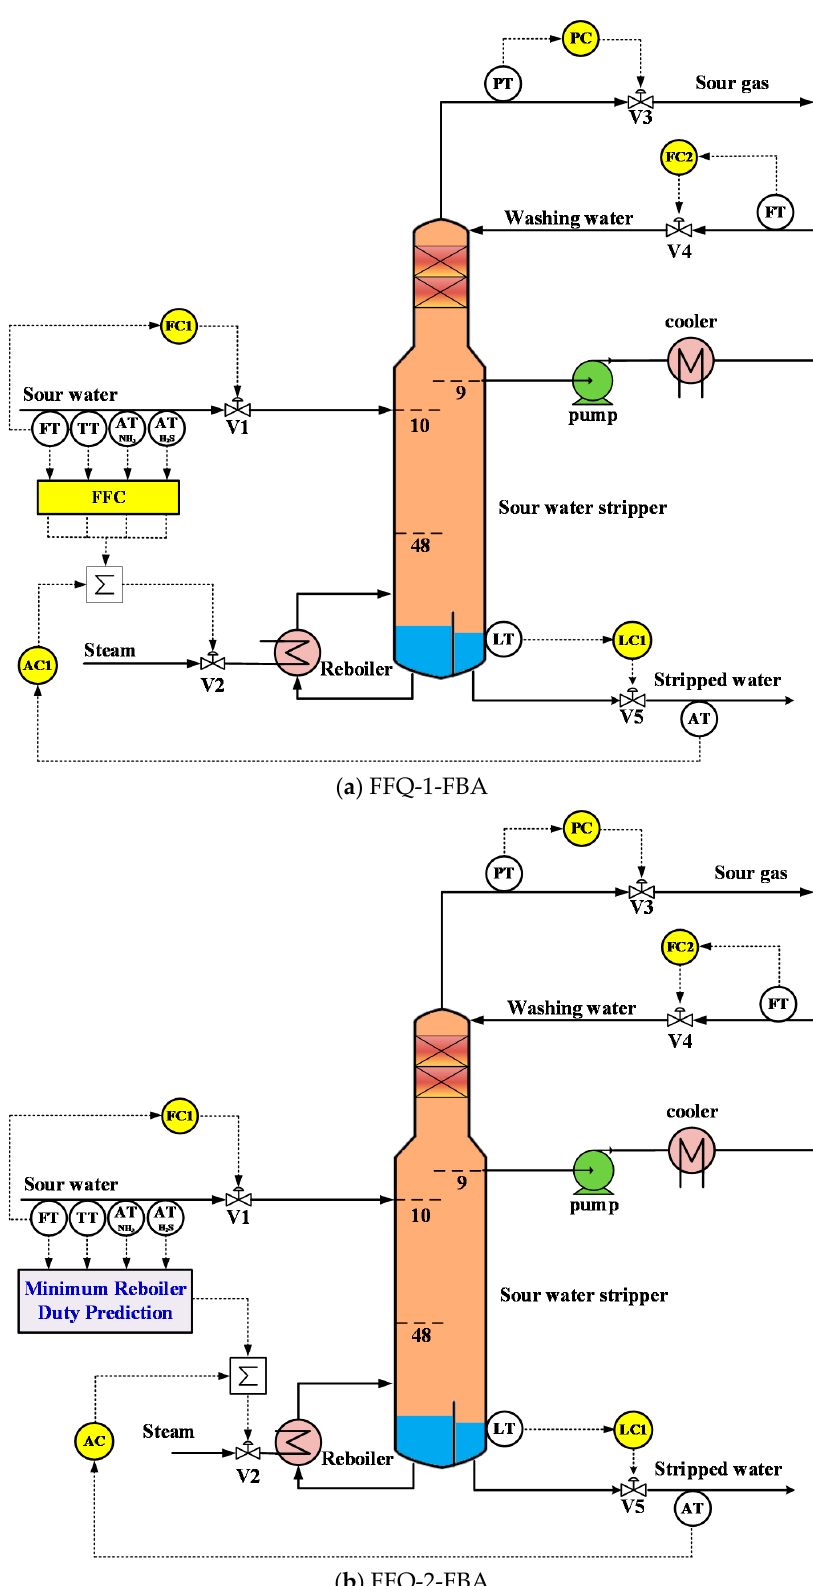
Figure 7. Feedforward-feedback control schemes.